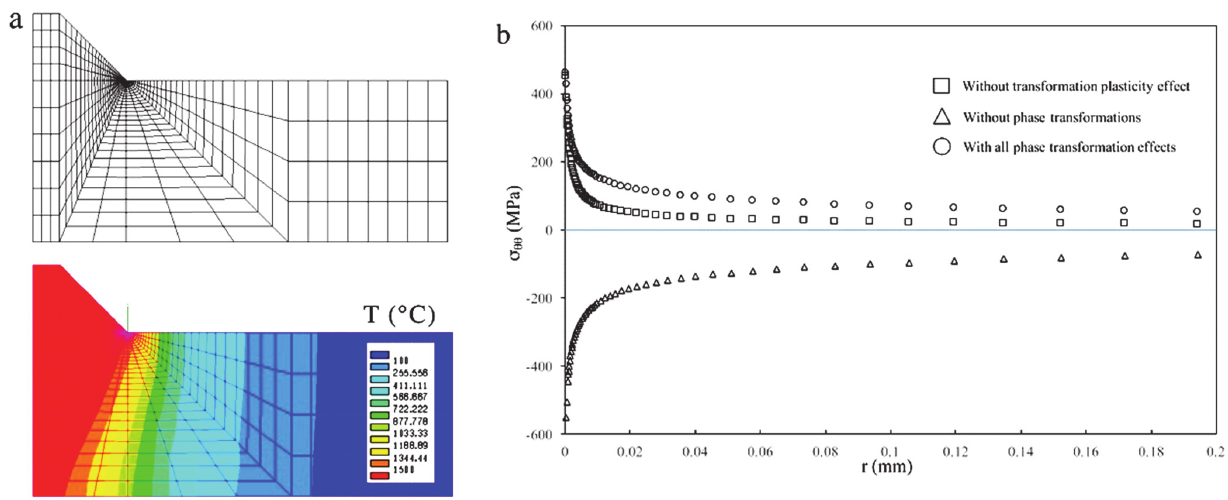
Figure 3: (a) Mesh of the numerical model and fusion zone dimension and shape (butt-welded joint); (b) Phase transformation effects on residual stresses along the bisector of the V-notch ( 2 β =135°) (material: ASTM 11 SA 516, free edges). Residual stresses redistribution